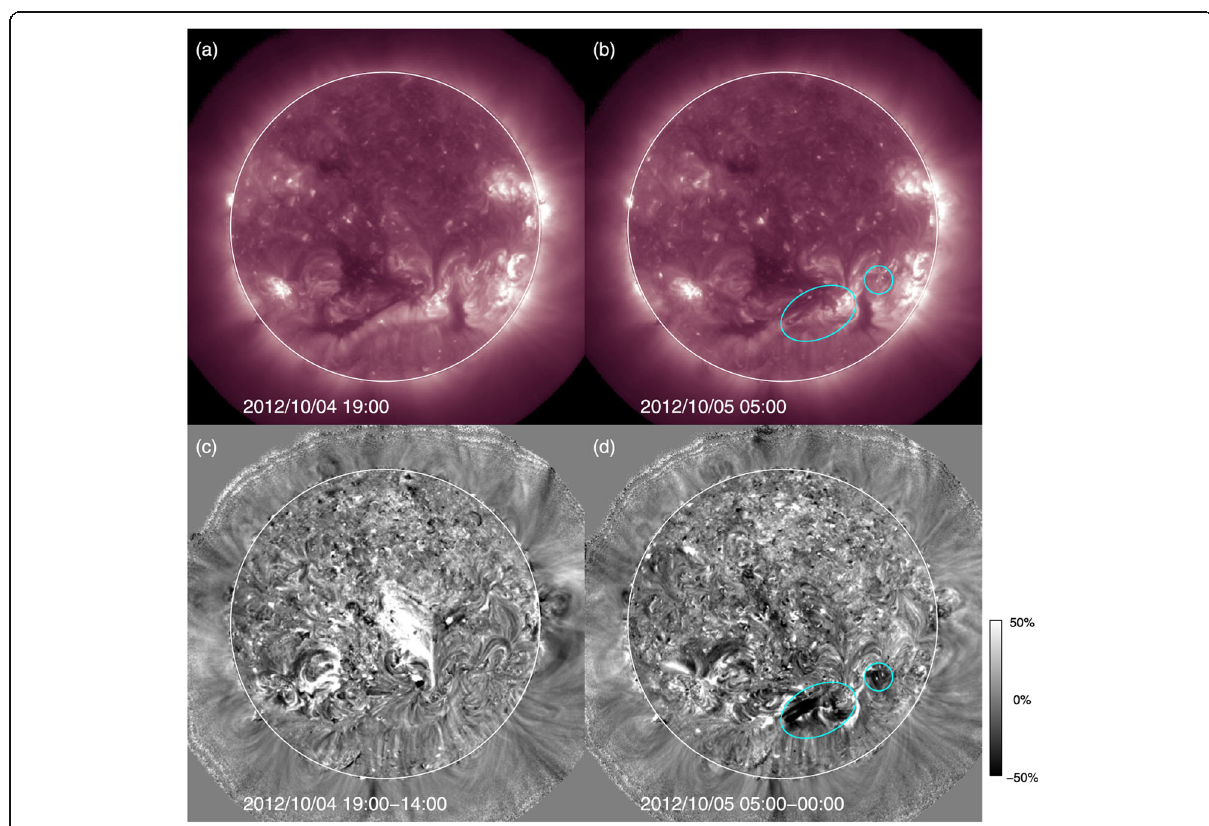
Fig. 17 AIA 211 Å intensity and percent difference images in the upper and lower panels, respectively, taken before and during the CME on 5 October 2012. Differences are made relative to an image 5 h earlier. The dimming regions found in difference images are encircled in cyan. From Nitta and Mulligan